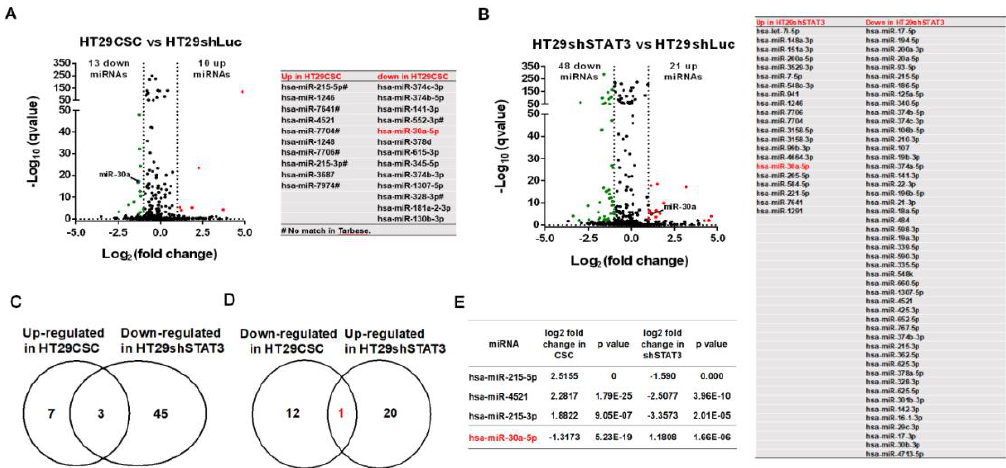
Figure 3. STAT3-mediated miRNA expression profile in HT29CSC revealed miR-30a-5p as a potential tumor suppression regulator. ( A , B ) A miRNA-seq was used to search and validate di ff erential miRNAs involved in tumorsphere formation. A total of 10 of 21 miRNAs were upregulated and 13 of 48 miRNAs were downregulated in HT29CSC ( A ) and HT29shSTAT3 ( B ) cells. ( C – E ) Comparison of miRNAs profiles between HT29CSC and HT29shSTAT3 cells revealed that three miRNAs (miR-251-5p, miR-4251, miR-251-3p) were upregulated in HT29CSC cells ( C , E ) but downregulated in HT29shSTAT3 cells ( D , E ). By contrast, only miR-30a-5p was downregulated in HT29CSC cells but upregulated in HT29shSTAT3 cells ( E ).